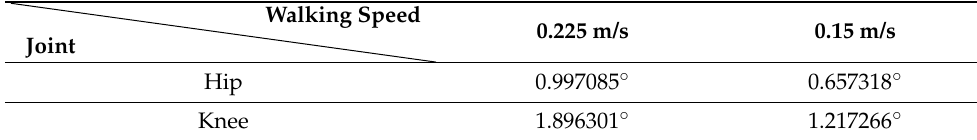
Table 2. RMSEs of joint trajectories for different walking speeds.